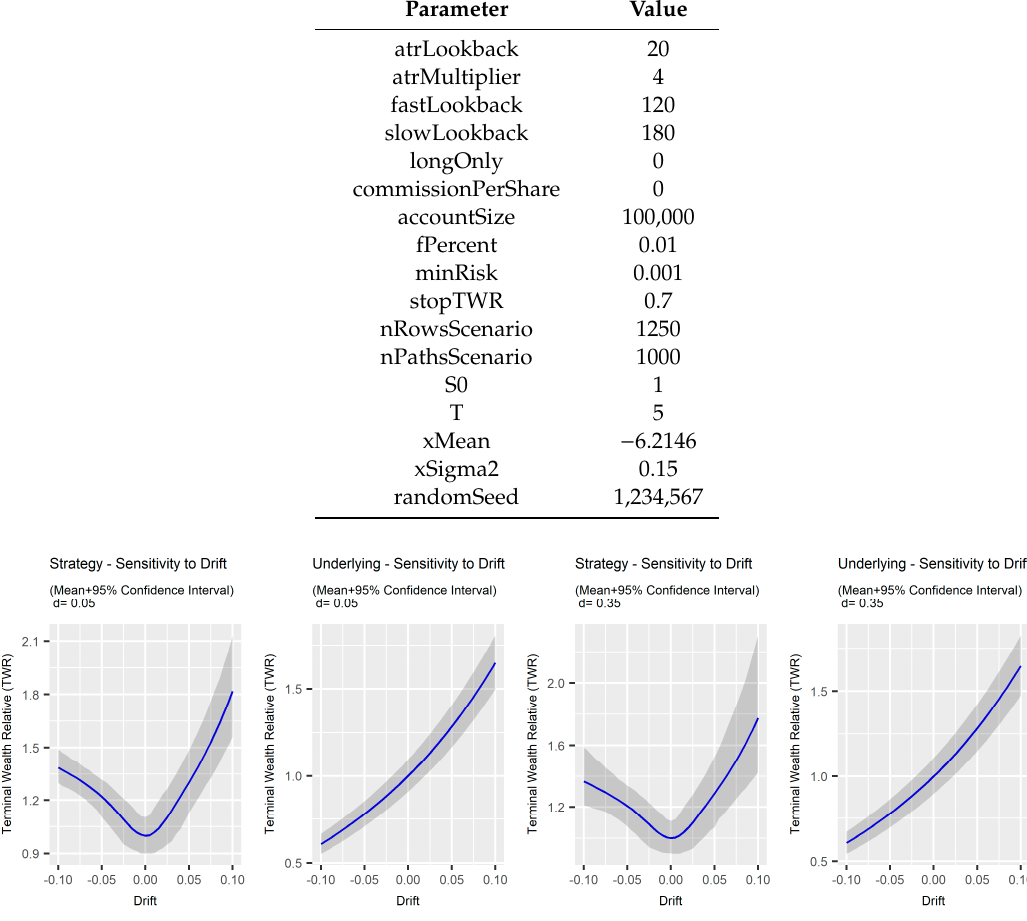
Figure 8. Profile of trend sensitivity .